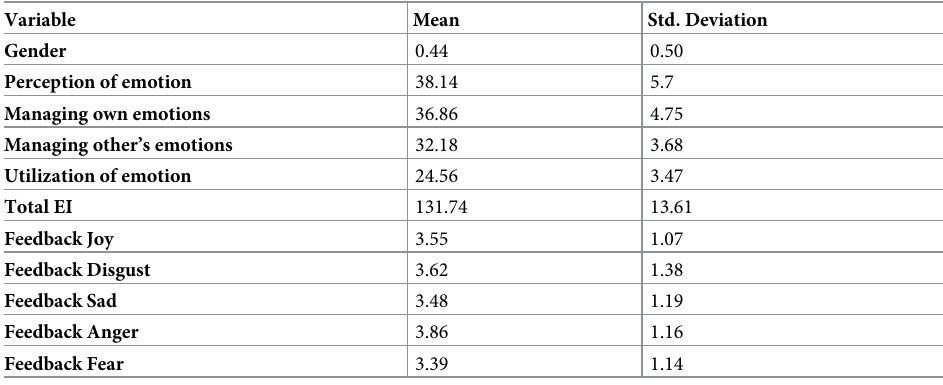
scale (1: not at all, 5: extremely) immediately after the video got over. Feedback form ratings indicated that the intended emotion was successfully induced with varying intensity. One sam- pled t–test showed that the ratings were significantly different from 0 for all the emotion elici-